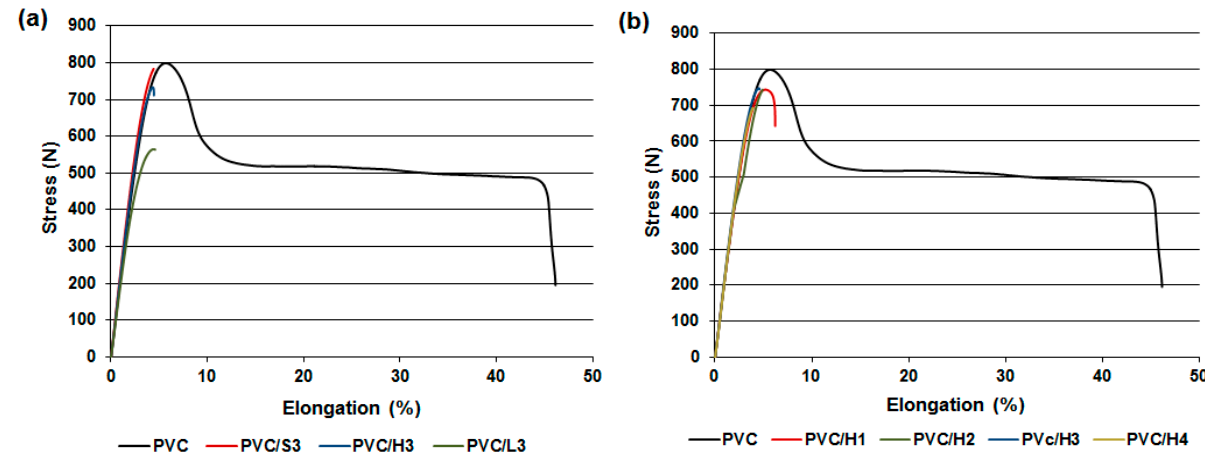
Figure 9. Mechanical stress-strain curves of PVC composites with 7.5 wt % content of silica and lignin individually, as well as silica–lignin fillers ( a ) and for composites with different content of hybrid fillers ( b ).